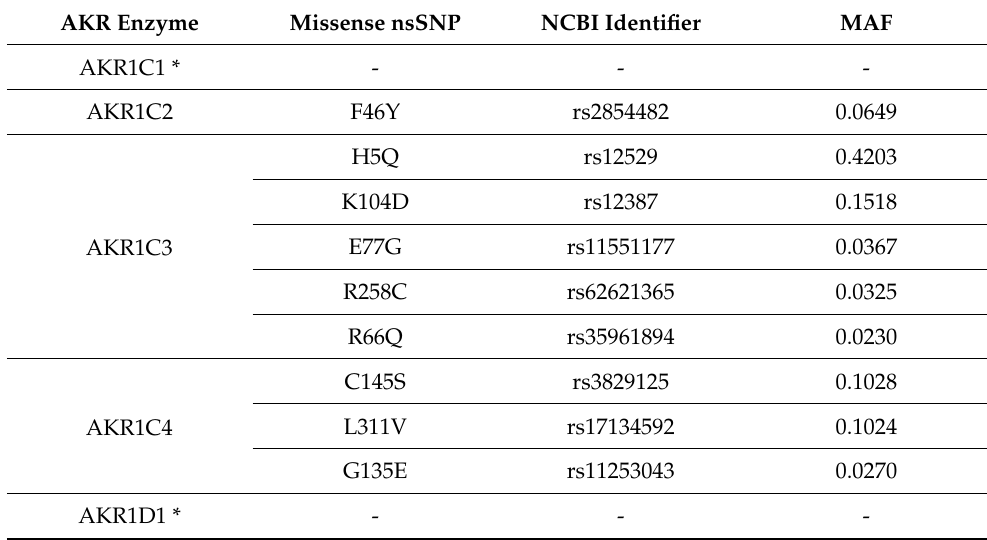
Table 2. Steroid-transforming human AKR nsSNPs with an MAF greater than 0.01, * indicates that nsSNPs with a frequency of <0.01 exist but are not included in the